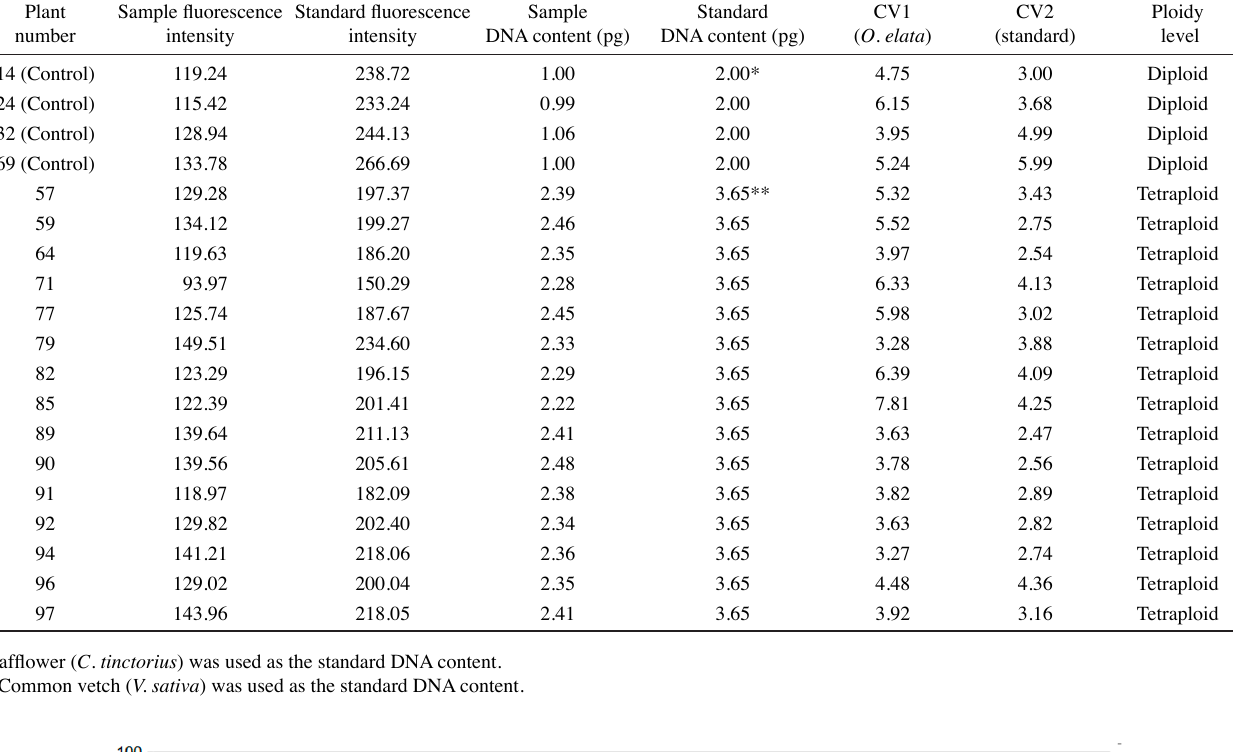
plants were transferred to field conditions for further morpholo- gical, cytological, and palynological observation, and to hybridiza- tion facilities in the sainfoin breeding